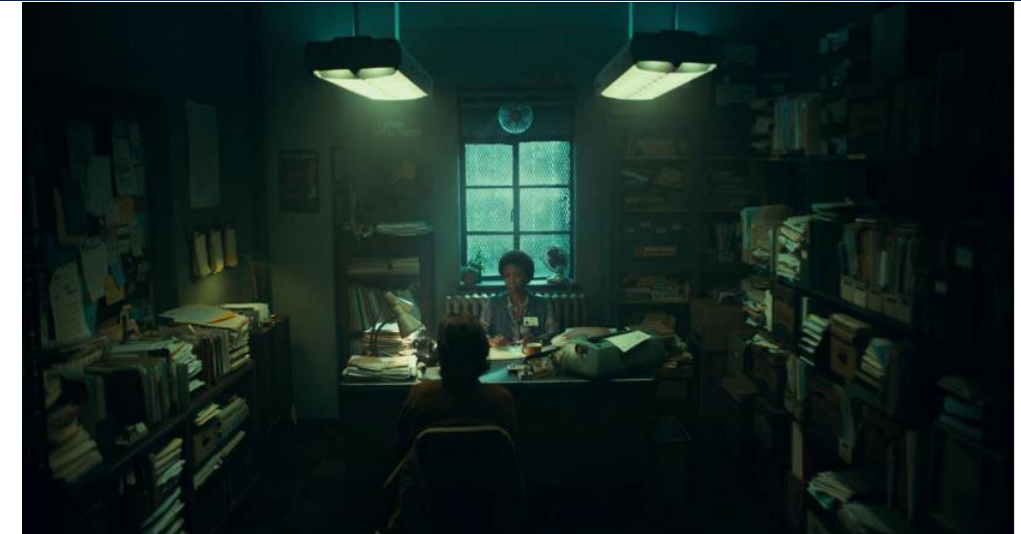
Figure 60 Arthur’s sense of lack of control over his world reflected in the claustrophobia of the therapist’s